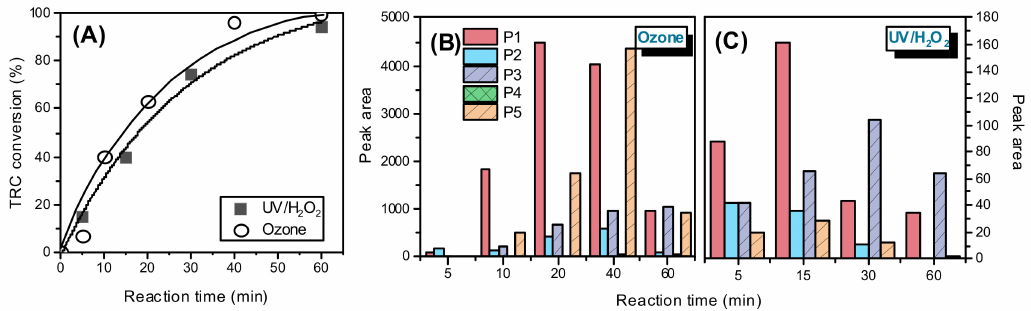
Figure 2. ( A ) Dependence of TRC conversion on oxidation time (for ozone and UV/H 2 O 2 ); ( B ) Peak area of the identified products during ozonation; ( C ) Peak area of the identified products during UV/H 2 O 2 treatment. Table 2. Formulae, retention times and m / z values of tetracycline hydrochloride (TRC) and its oxidation products (OPs). Molecule Retention Time, min